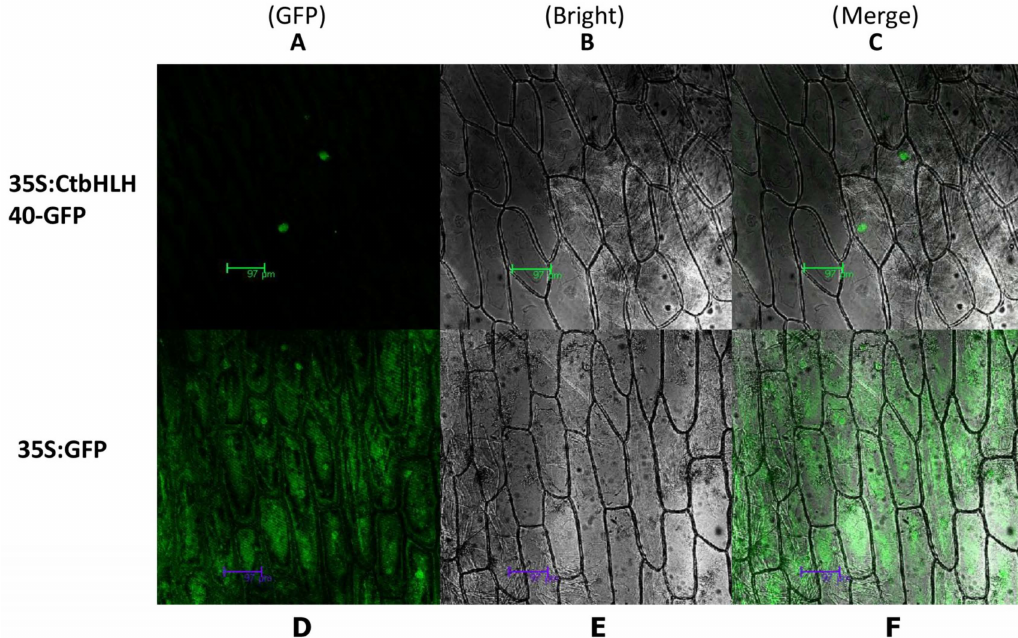
Figure 8. Subcellular compartment of CtbHLH40 based on transient expression in onion epidermal cells. ( A – C ) Onion cells introduced with 35S:CtbHLH40–GFP. ( D – F ) Induction of the control